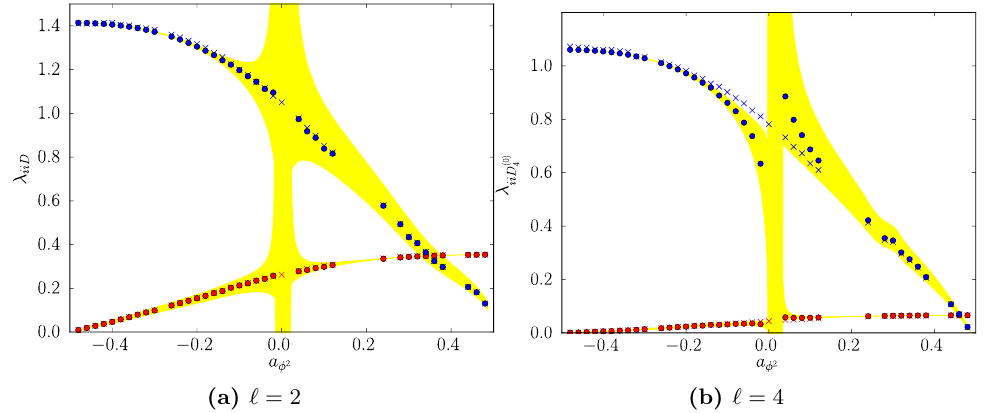
Figure 8. Plots demonstrating the extent to which the Ward identities hold at the kinks. Red and blue crosses are the numerically determined λ circles are obtained by computing a displacement central charge using their ratio and plugging this back into (2.11) and (2.13). The yellow envelope shows how much the circles can vary if the OPE coefficients are allowed to fluctuate within 5% of their extracted values. As such, large disagreements should not be concerning if they occur near a method does not yield rigorous errors, 5% was chosen